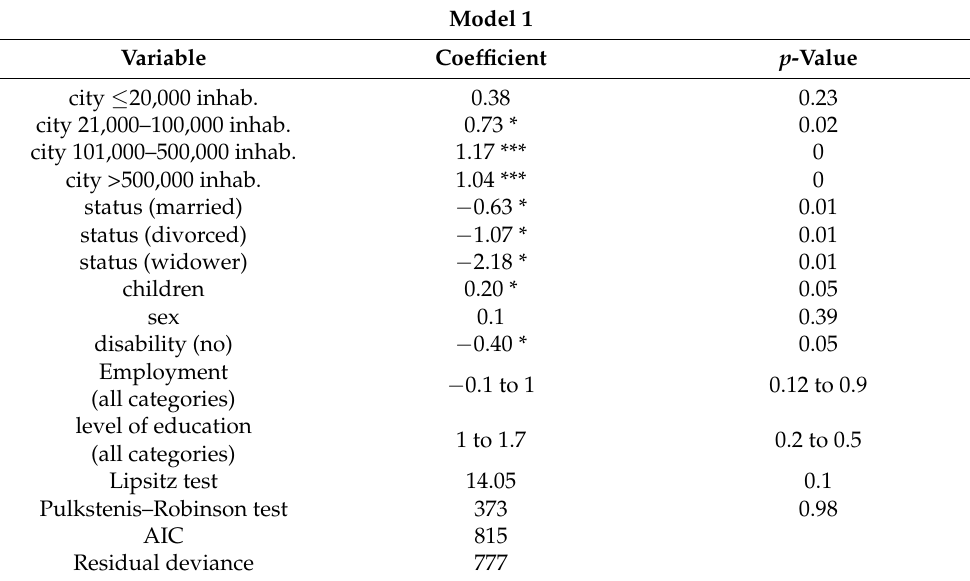
Table 3. Results of logistic regression.